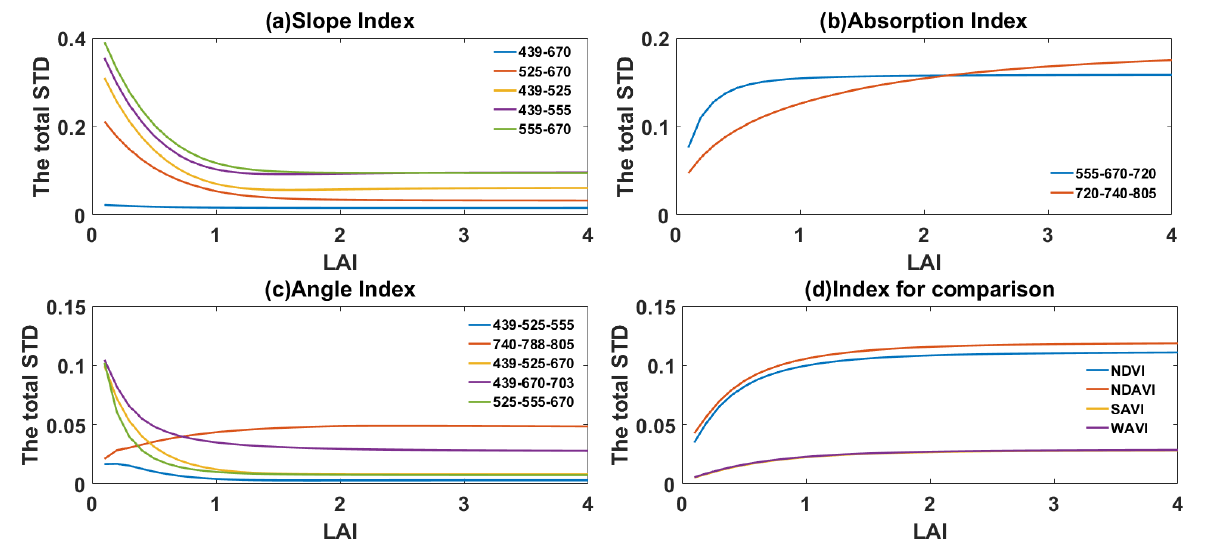
Figure 3. The patterns of total standard deviations variation as function of LAI for different indices. (a): Slope index; (b) Absorption index; (c) Angle index; (c) Index for